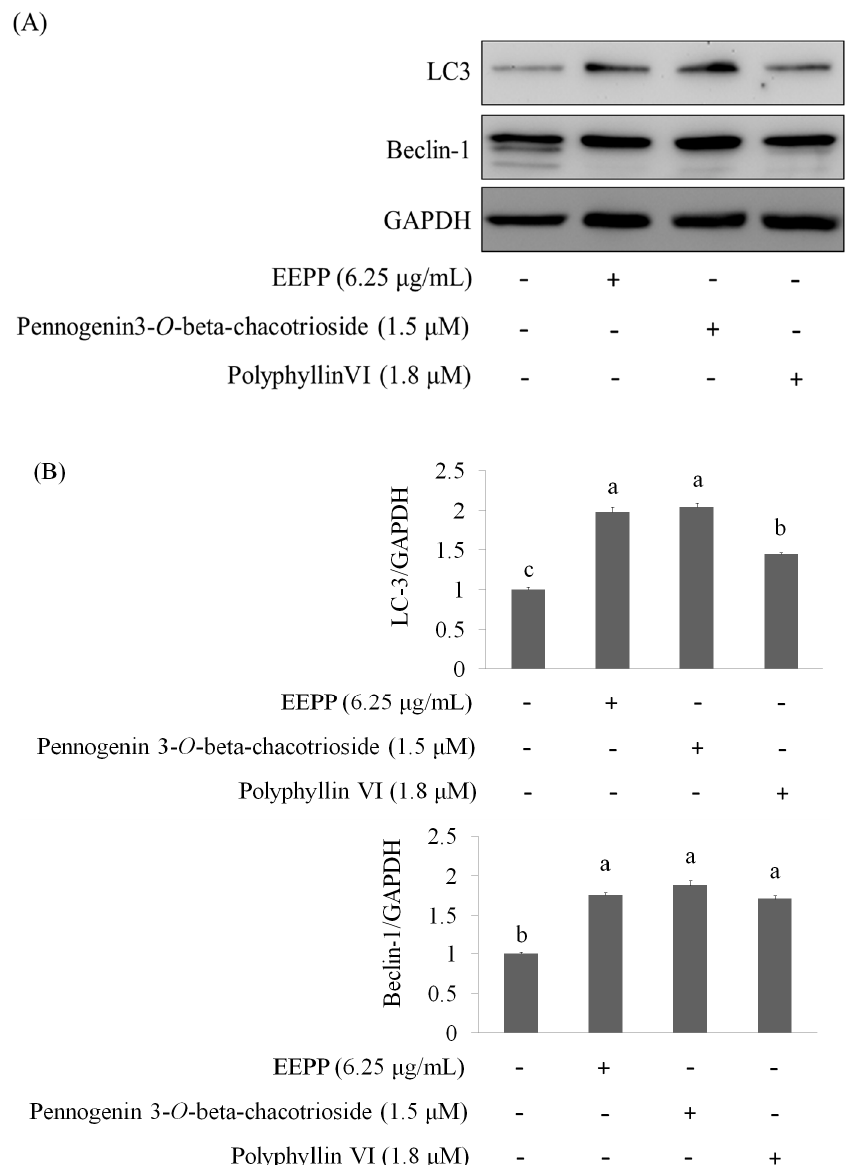
Figure 8. Elevation of autophagy markers in DLD-1 colorectal carcinoma cells treated with pennogenin 3- O - β -chacotrioside or polyphyllin VI for 24 h. The concentrations of pennogenin 3- O - β -chacotrioside and polyphyllin VI were calculated according to EEPP. ( A ) Pennogenin 3-O- β -chacotrioside or polyphyllin VI markedly increased the expressions of LC3 and Beclin-1. ( B ) Quantitative analysis for each protein levels. Data are shown as means ± SD ( n = 3). The significant di ff erences are denoted by di ff erent letters ( p < 0.05).